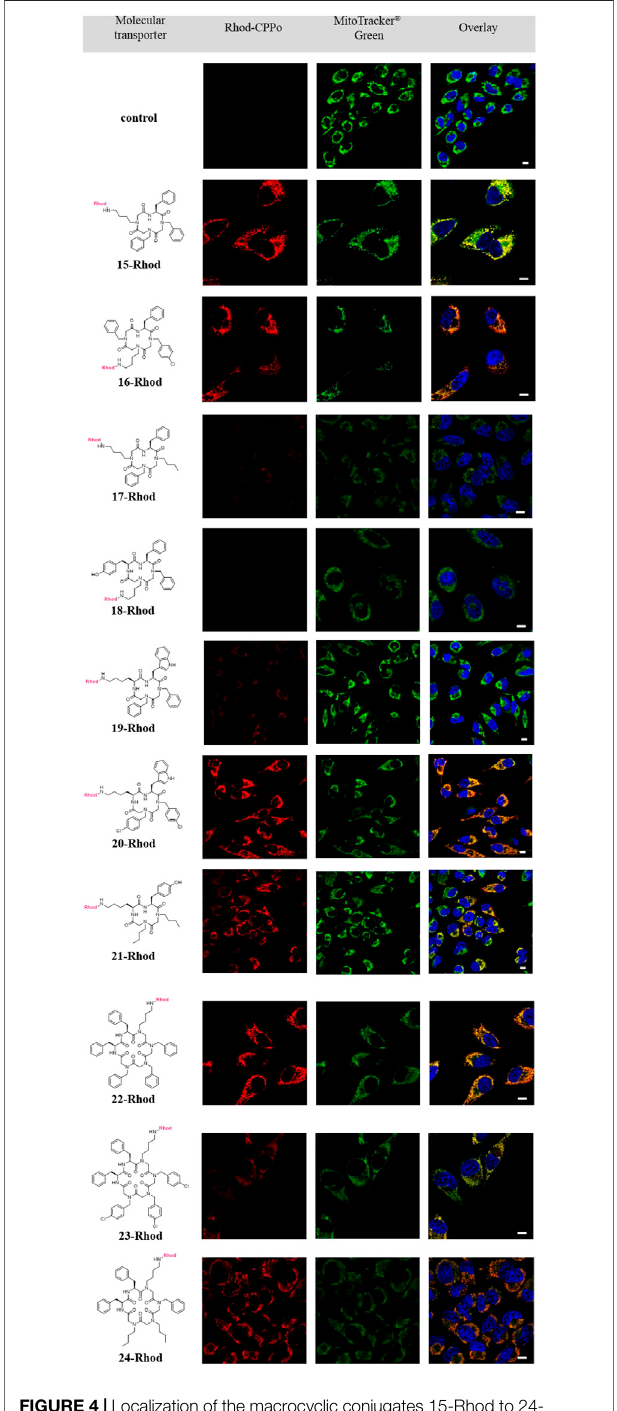
FIGURE 4 | Localization of the macrocyclic conjugates 15-Rhod to 24- Rhod in HeLa cells. After incubation with a 5.0 µ M solution of the respective transportersfor5h,thecellularuptakewasmonitored via fl uorescentconfocal microscopy (Rhodamine B labeled hybrids: λ Exc (cid:2) 532 nm, λ Em (cid:2) 570 – 620 nm; MitoTracker ® Green: λ Exc (cid:2) 488 nm, λ Em (cid:2) 490 – 540 nm; Hoechst 33,342: λ Exc (cid:2) 405 nm, λ Em (cid:2) 430 – 490 nm). Counterstaining with MitoTracker ® Green visualized mitochondria (green). Staining with 2 μ g/ml Hoechst 33,342 indicated nuclei (blue). Scale bar: 10